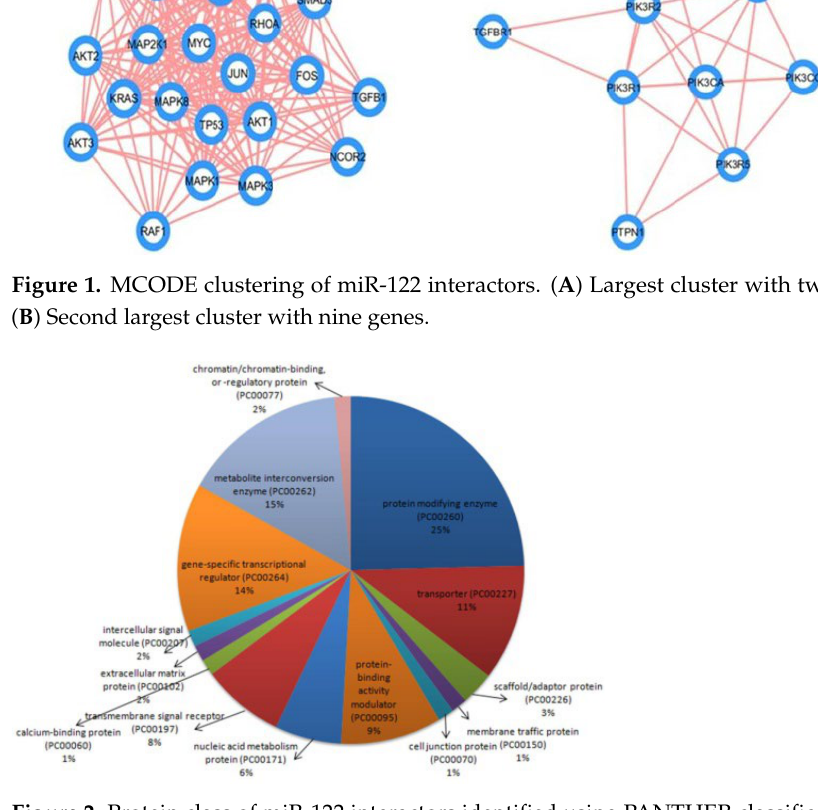
Figure 2. Protein class of miR-122 interactors identified using PANTHER classification system.